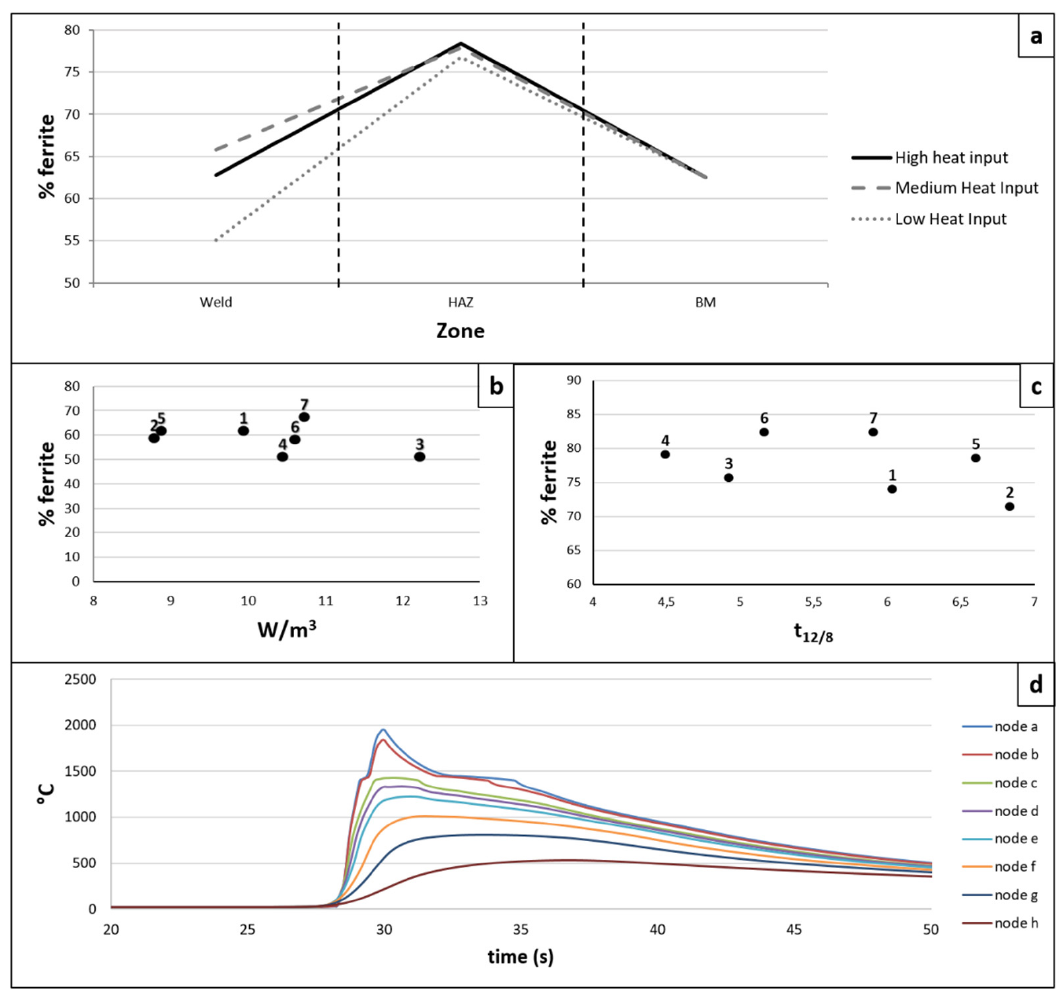
Figure 6. ( a ) Amount of ferrite obtained for the coupons with the highest, medium, and lowest thermal input, depending on the weld zone, ( b ) % ferrite in the weld bead vs. W/m 3 , ( c ) % ferrite vs. time t 12/8 , ( d ) thermal cycle suffered by the nodes in weld coupon 2.